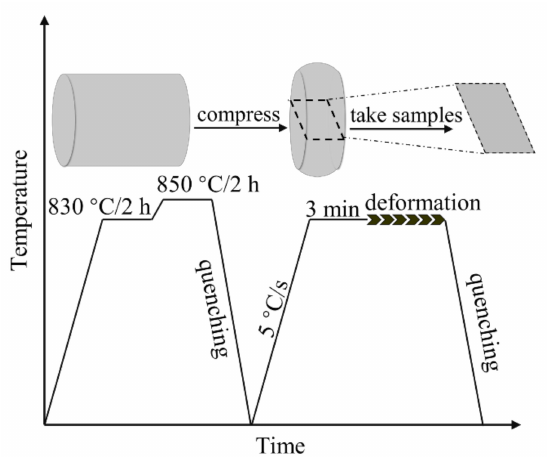
Figure 1. The schematic diagram of the technological process of the whole experiment. The samples for microstructure observation were cut parallel with the compression direction and through the center of the deformed specimens as described in Figure